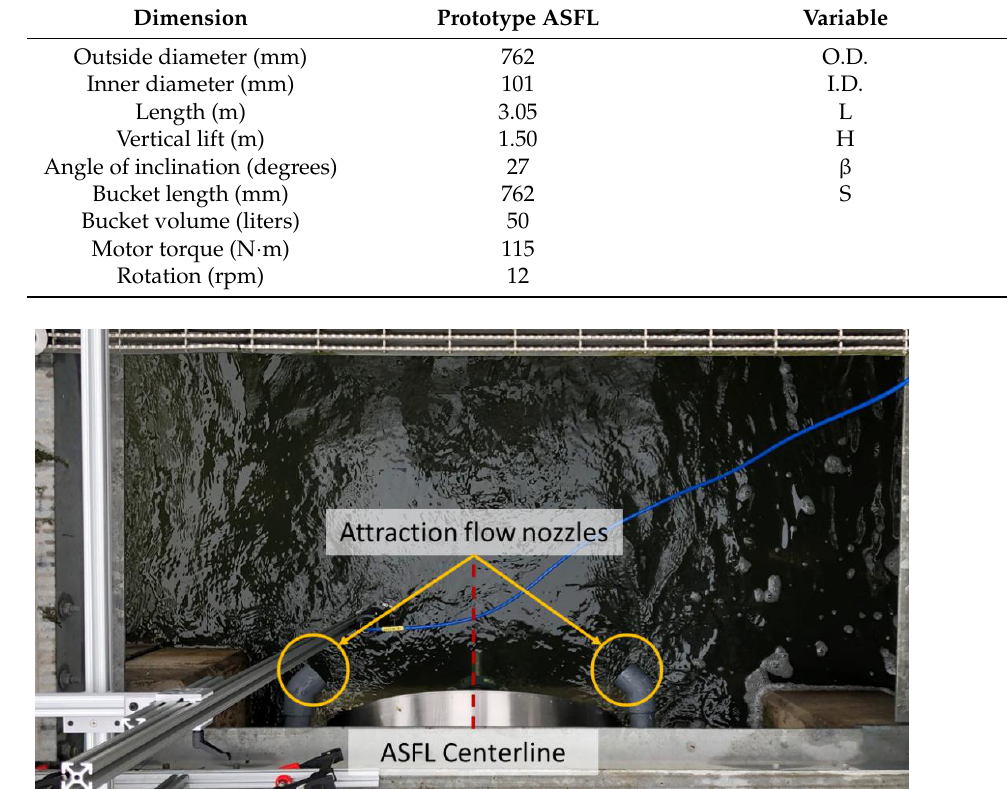
Figure 3. Location and orientation of attraction flow nozzles at the entrance of the